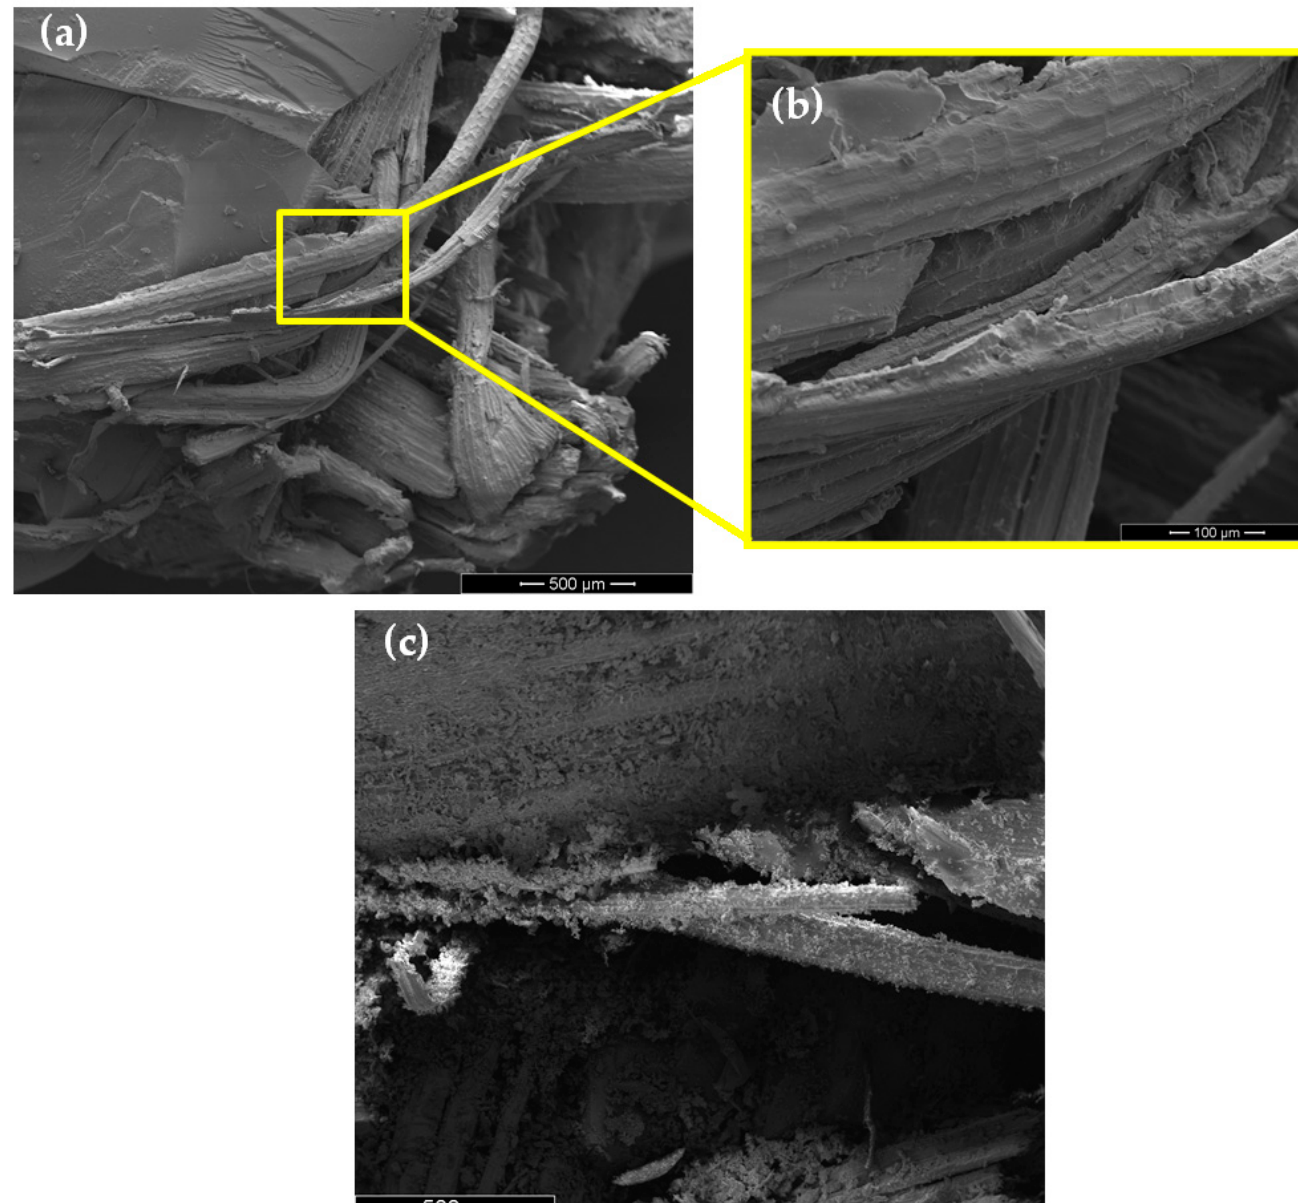
Figure 9. SEM image of the damage in the epoxy composite with 15 vol% of fique fabric ( a , b ); and with 40 vol% of fique fabric ( c ).